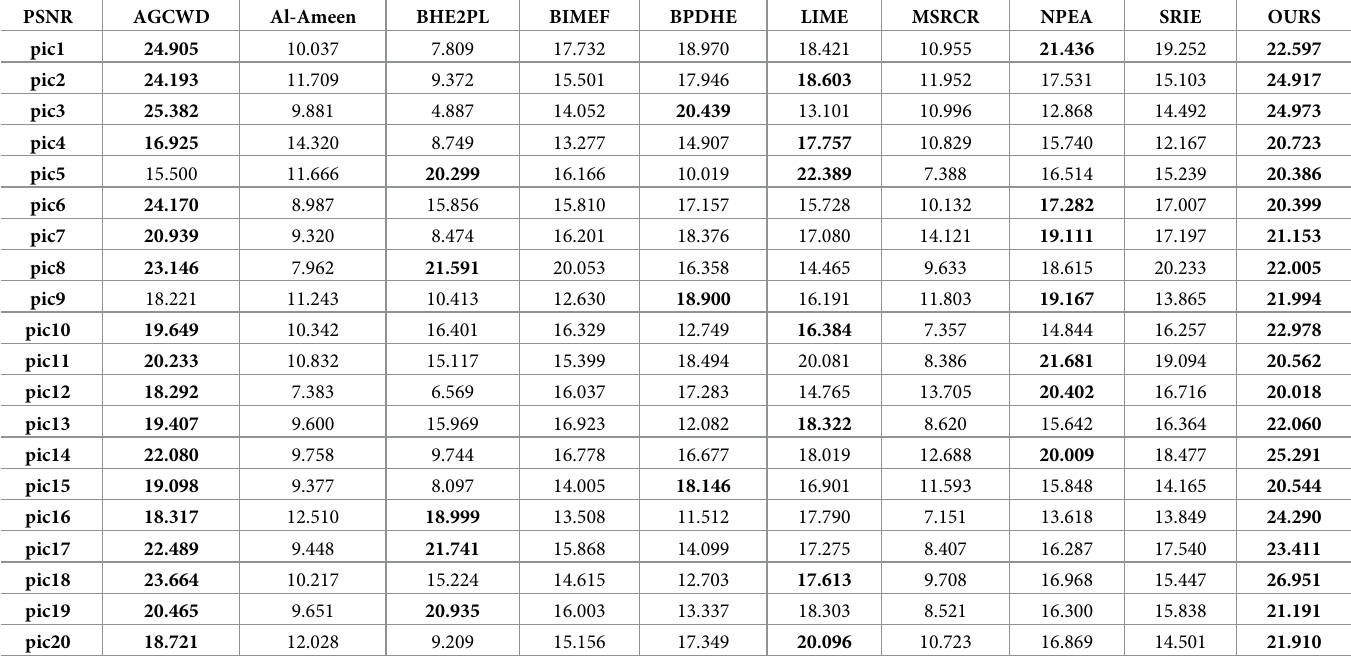
Table 3. PSNR values of 20 random images of MIT-5K.